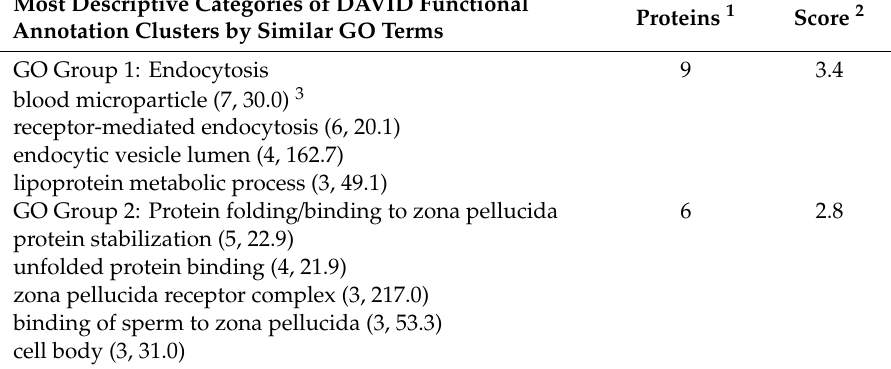
Figure 4. Bar chart representing the distribution of the proteins identified in spermatozoa incubated with seminal plasma (SP) according to the biological process, cellular component, and molecular function. Table 3. DAVID functional annotation clustering for sperm-interacting proteins within uterine fluid (UF). Most Descriptive Categories of DAVID Functional Proteins